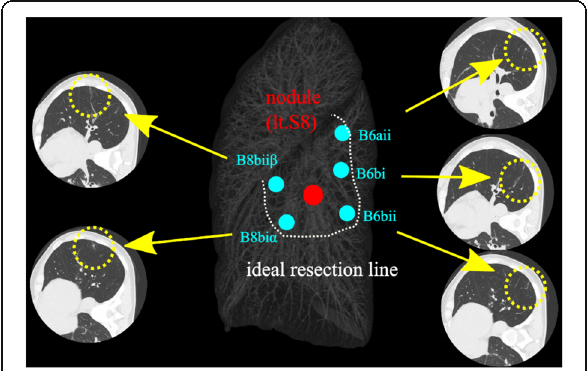
Fig. 3 Three-dimensional configuration of the CT for “ mapping ” for the second